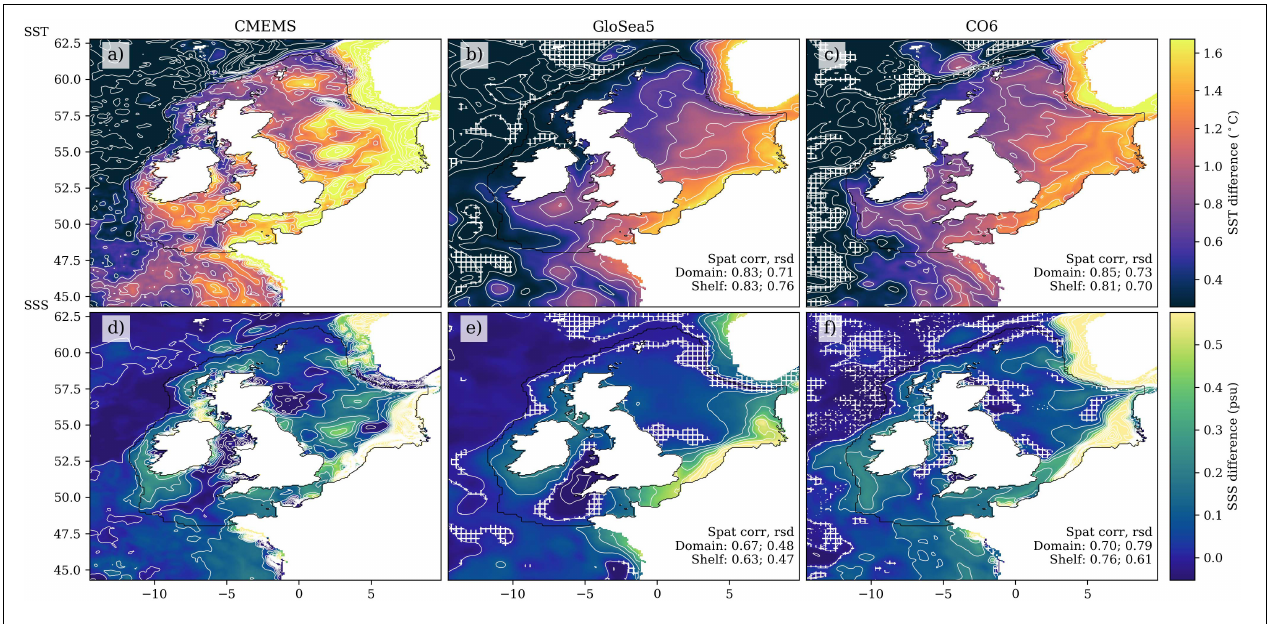
FIGURE 10 | Spatial patterns of the difference of two winter (DJF, 2011/2012 minus 2010/2010) from CMEMS (a,d) , GloSea5 (b,e) , CO6 (c,f) for SST (a–c) and SSS (d–f) . The GloSea5 data has been bilinearly interpolated onto the CO6 grid. White hatching (in panels b–f ) shows where there is no statistical difference between the 2011/2012 and 2010/2011 ensemble (using a point-wise Two-tailed Student’s T -Test). The spatial correlation and relative standard deviation, compared to CMEMS, for the full domain, and the shelf region, is given for GloSea5 and CO6 (b,c,e,f) . NBT is given in Supplementary Figure 13 . TABLE 2 | Summary spatial statistics of the area mean difference between the two case study years, summarising the values displayed in Figure 10 . Shelf Std Shelf 5th Shelf 50th Shelf 95th Domain Domain Domain 5th Domain 50th Domain 95th Dev Percentile Percentile Percentile Mean Std Dev Percentile Percentile